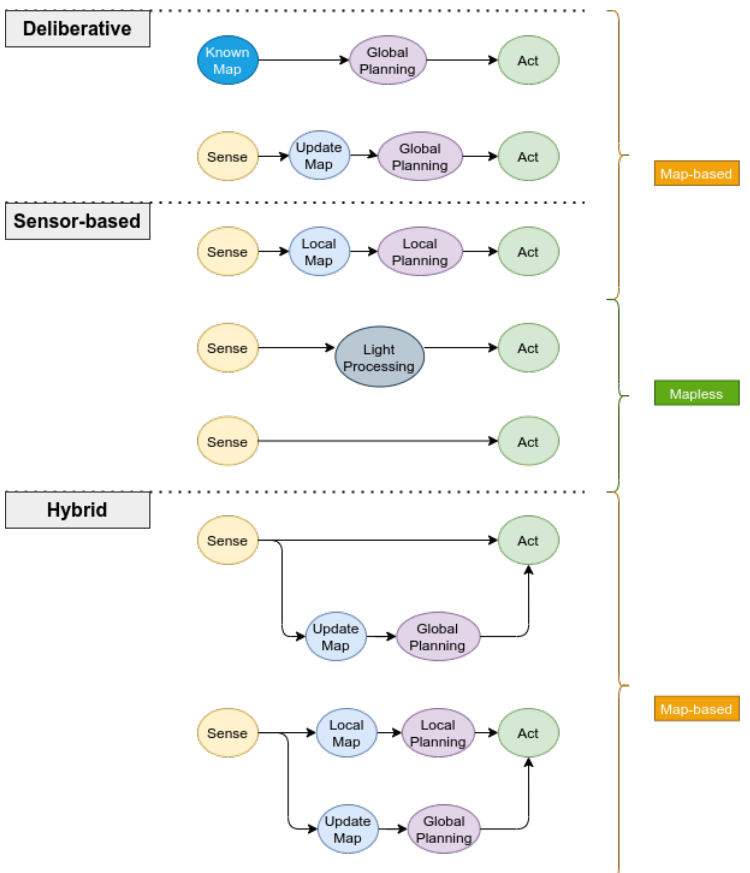
Figure 6. Different paradigms adopted for autonomous navigation from a high-level